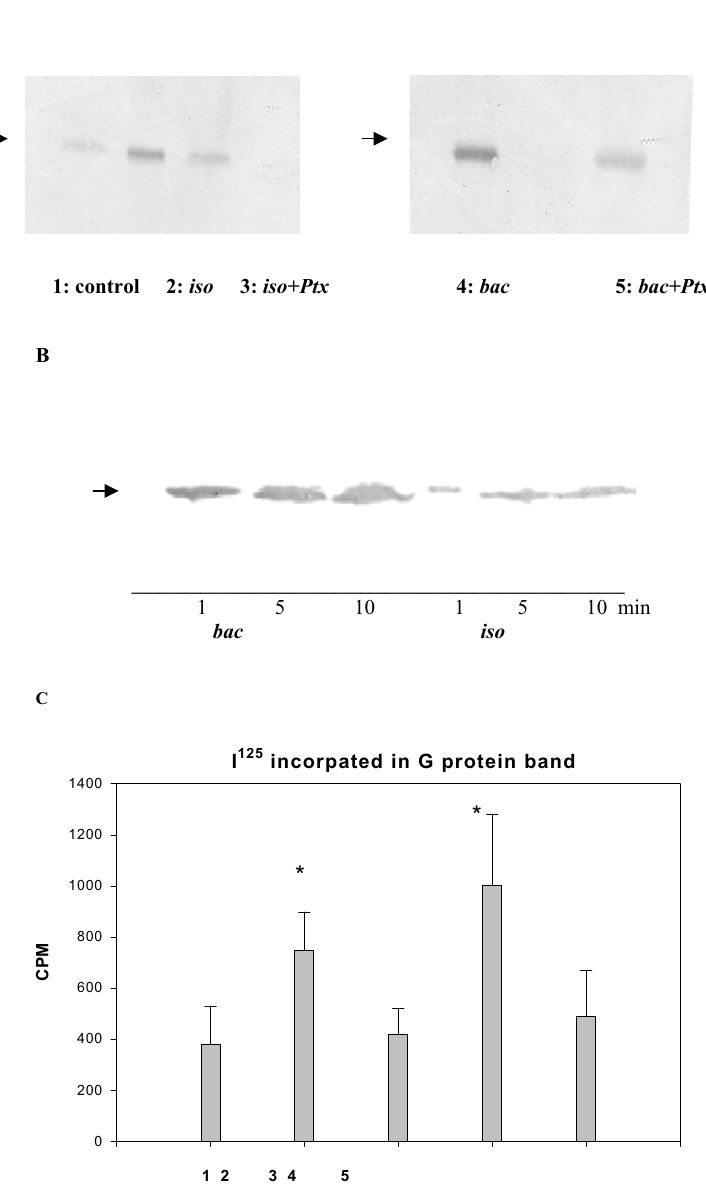
Figure 3 G beta/gamma binding to cyclase(s): Western analysis and quantification A: Analysis of G beta bound to cyclase Western blot analysis of beta/gamma bound to cyclase(s) complex. Plasma membrane (50 µ g protein) was incubated with iso- proterenol or baclofen (200 nM) plus Mg (1 mM) and GTP (10 µ M) for 10 min at 20°C. A 'pull down' experiment was performed in ice with Forskolin-agarose and solubilized membranes as described in 'materials and methods'. The material bound to the affinity beads was submitted to gel electrophoresis followed by Western blot analysis using anti- beta antibody. Membrane con- trol ( lane 1 ), isoproterenol ( lane 2 ), isoproterenol + pertussis toxin ( PTx ) treatment ( lane 3 ), baclofen ( lane 4 ) and baclofen + pertus- sis toxin ( PTx ) treatment ( lane 5 ). The arrow corresponds to MW = 35 kDa. B: Time course of association G beta /cyclase Same protocol as in A except that membranes were incubated with baclofen ( left ) and isoproterenol ( right ) at 200 nM. for 1.5 and 10 min before the cyclase complex was isolated by affinity chromatography. C: Quantification of G beta bound to cyclase (in A) To quantify the beta subunit bound to affinity beads, we used Bolton Hunter labeling of the affinity isolated material obtained under the conditions described in A, then carried out gel electrophoresis. The band about MW = 35 kDa was excised and counted. The bars represent 3 determinations +/-SE. * corresponds to values statistically different from control, P < 0.05. Lane 1 : membrane control, lane 2 : isoproterenol, lane 3 : isoproterenol + pertussis toxin (PTx), lane 4 : baclofen , lane 5 : baclofen + pertussis toxin